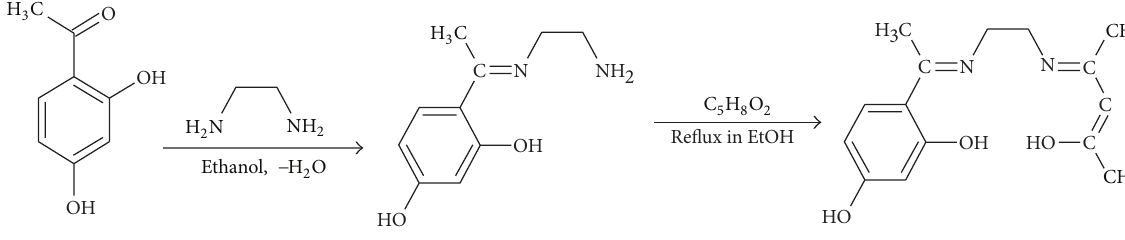
Scheme 1: Synthesis of Schiff base ligand (H 2 LL).